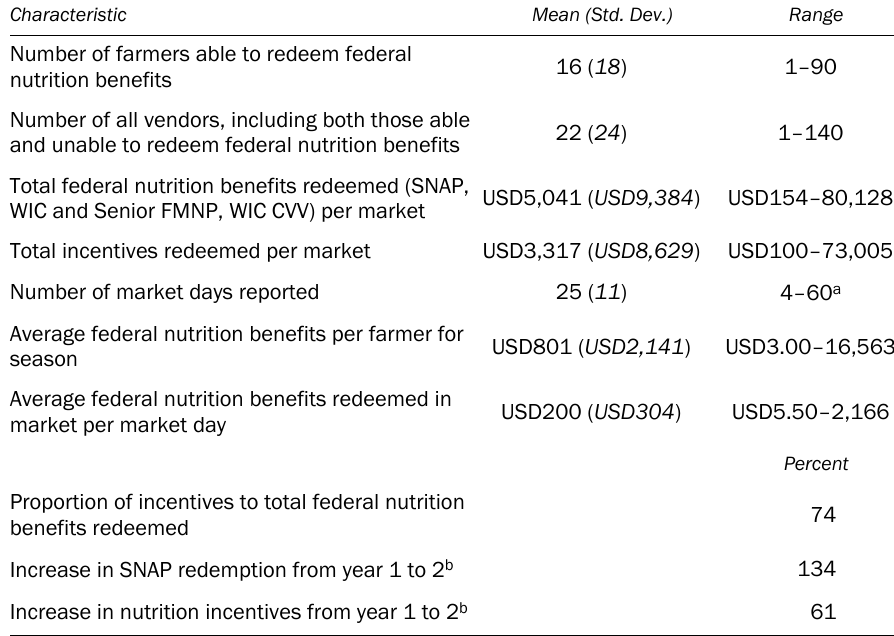
Table 2. Characteristics of Farmers’ Markets with Incentive Programming (N=95)